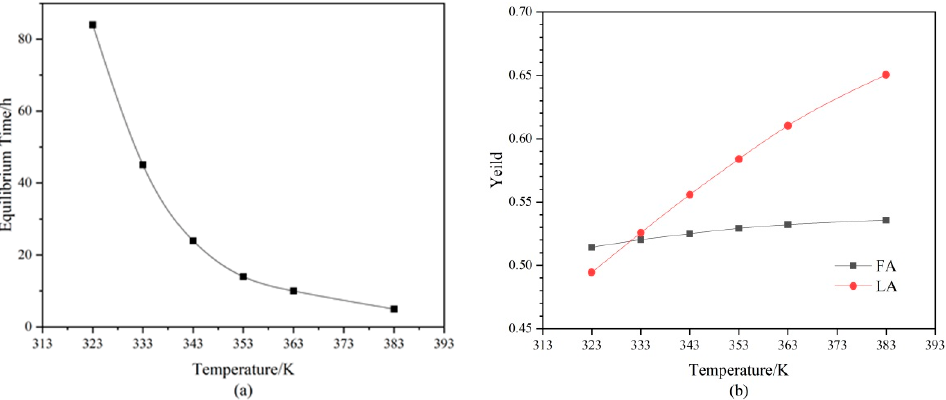
Figure 8. Effect of temperature on the yields of ( a ) LA and ( b )